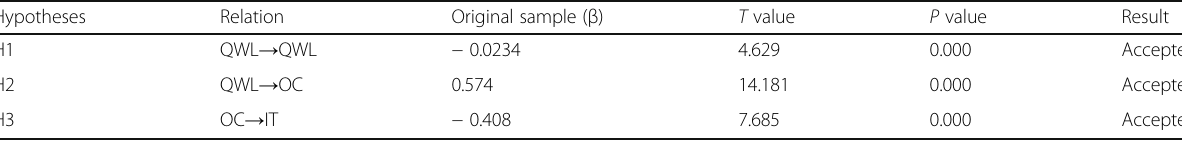
Table 2 Summary of structural model assessment of direct hypotheses Hypotheses